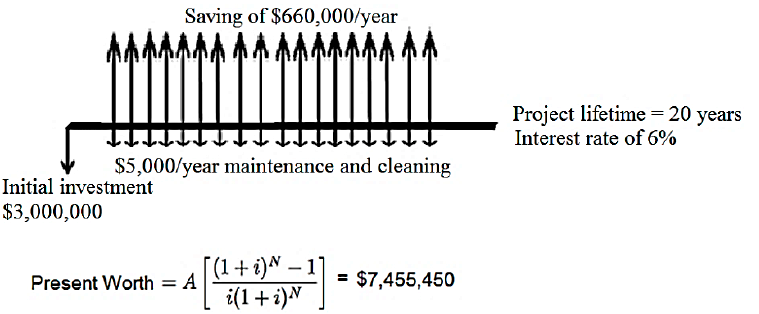
Figure 5. Cash flow diagram including the present worth of the future money with an interest rate of 6% over a period of 20 years.